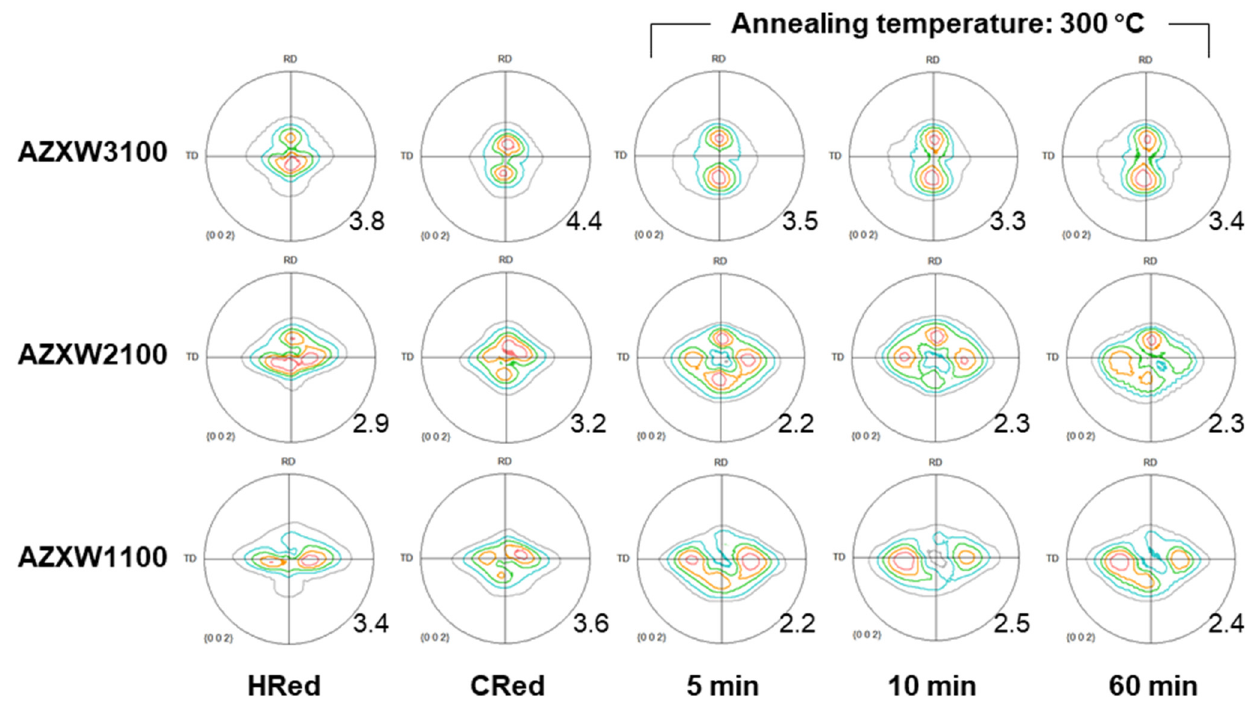
Figure 5. X-ray pole figures of the hot-rolled, cold-rolled, and annealed sheets. From the calculation results for Ca solutes (Table 2) dissolved in the matrix at 420 ◦ C, it can be concluded that the critical Ca amount required to form the TD-split texture component was 0.008 wt.%. Guo [28] reported that the AZ31 + 0.5 wt.% Ca alloy exhibited